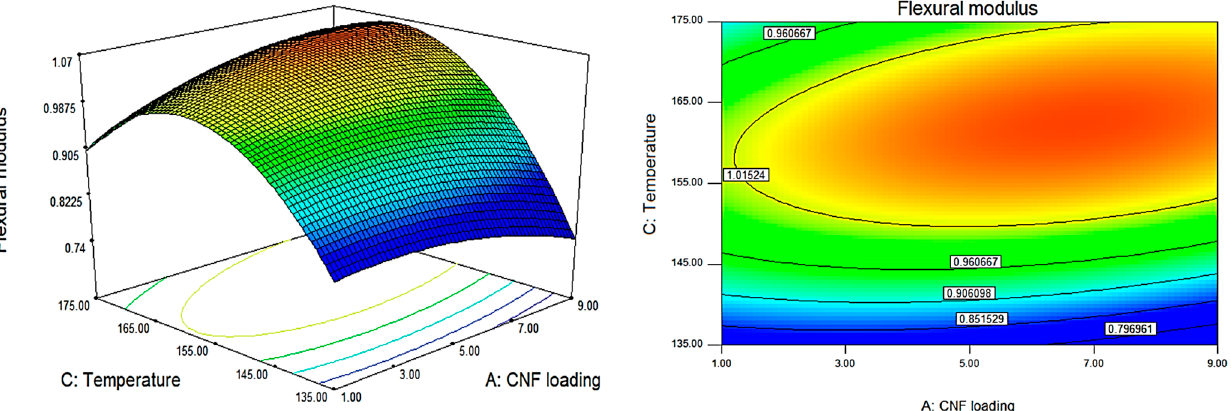
Figure 3. The 3D and response surface contour plots for the dependence of P(HB- co -11% HHx)/CNF bionanocomposite’s flexural strength on CNF loading and rotational speed as significant factors. Figure 4. The 3D and response surface contour plots for the dependence of P(HB- co -11% HHx)/CNF bionanocomposite’s flexural modulus on CNF loading and temperature as significant factors.